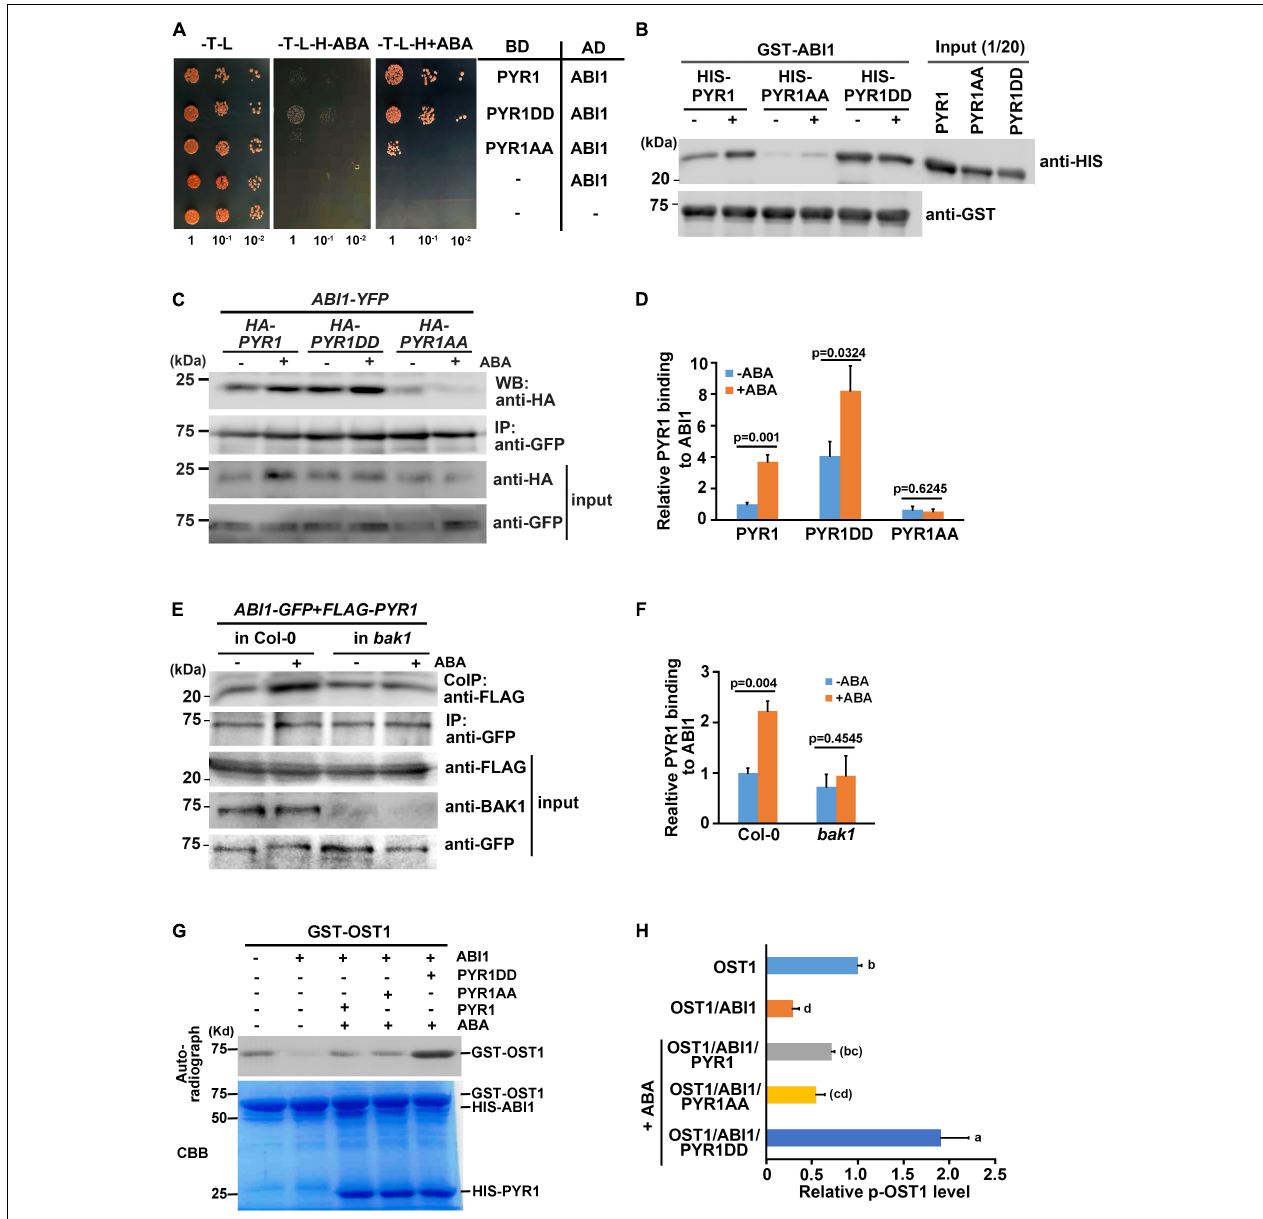
FIGURE 7 | BAK1 phosphorylation on PYR1 enhanced ABA-induced interactions between PYR1 and ABI1. (A) PYR1 phosphorylation by BAK1 promotes ABA-induced interaction between PYR1 and ABI1. Yeast cells were grown up to 0.6 at OD600 (set as 1) Tenfold, serially diluted cell cultures were inoculated on each spot as indicated. (B) PYR1DD increased interaction with ABI1 in vitro . In vitro pull-down assays were performed using recombinant PYR1 variants in the absence or presence of 30 µ M ABA. GST-ABI1 protein was detected using an anti-GST antibody, and pulled-down HIS-PYR1 variants were analyzed by western blotting after incubation using an anti-HIS antibody. On the same blot, 1/20 of HIS-PYR1 variants that were used for incubation are shown. (C) PYR1DD shows increased interactions with ABI1 in planta , even in the absence of ABA. ABI1-YFP and HA-PYR1 , HA-PYR1AA , or HA-PYR1DD were transiently co-expressed in tobacco leaves. Leaves were treated with 30 µ M ABA for 3 h before tissue harvest. Total crude plant extracts were prepared, and ABI1-YFP was immunoprecipitated using anti-GFP antibodies, followed by western blotting with anti-HA antibodies to detect co-immunoprecipitated HA-PYR1 variants. (D) The relative amounts of ABI1-bound PYR1, PYR1DD, and PYR1AA were quantified using Image J software from the picture in (C) and two independent experiments as shown in Supplementary Figure 8a . (E) BAK1 promotes binding of ABA-bound PYR1 by ABI1. Protoplasts prepared from wild-type and bak1 plants were transfected with FLAG-PYR1 and ABI1-GFP , then incubated with or without 30 µ M ABA for 3 h. Using the crude total protein extracts, ABI1 was immunoprecipitated using an anti-GFP antibody, and PYR1 was detected using an anti-FLAG antibody. A BAK1 antibody was used to confirm the absence of BAK1 protein in the bak1 mutant. (F) Relative amounts of ABI1-bound PYR1, PYR1DD, and PYR1AA were quantified using Image J software from the picture in (E) and two independent experiments as shown in Supplementary Figure 8b . (G) PYR1DD increased OST1 activation. In vitro kinase assays were performed with recombinant HIS-ABI1, GST-OST1, and HIS-PYR1 variants in the absence or presence of 30 µ M ABA. (H) Relative levels of phosphorylated OST1 were quantified by J from the picture in (H) and other two independent experiments as shown in Supplementary Figure 8c .